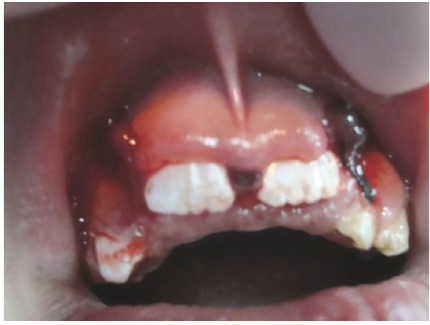
Figure 4: 2 days later. The new suture was also retired and then resutured. Pharmacological treatment was initiated intravenously.